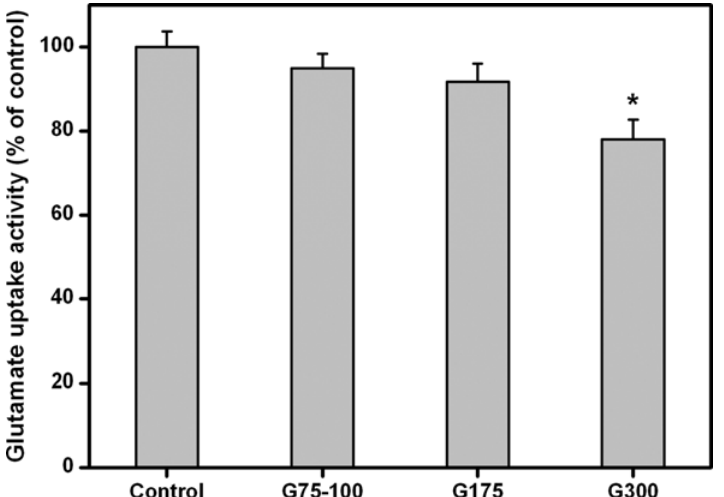
Figure 5. Glutamate uptake in the ARPE-19 cultures exposed to various dissolved gelatin materials for 2